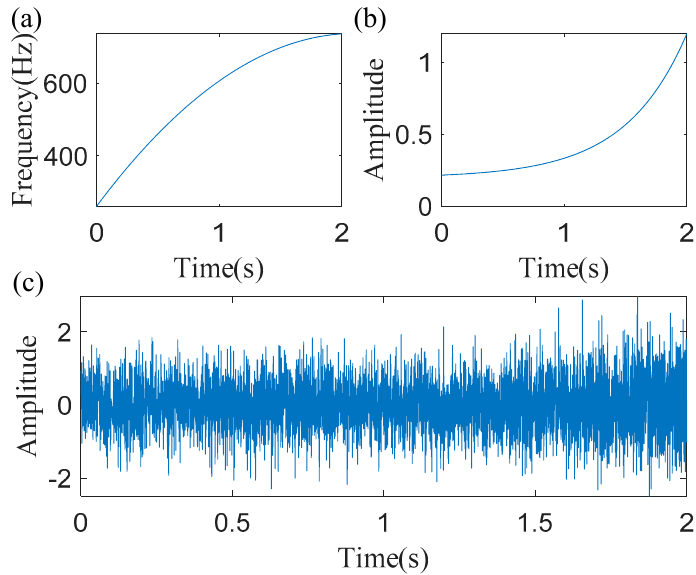
Figure 3. Characteristics of the simulated signal: ( a ) instantaneous frequencies (IF); ( b ) instantaneous amplitude (IA); and ( c ) simulated signal with a noise.